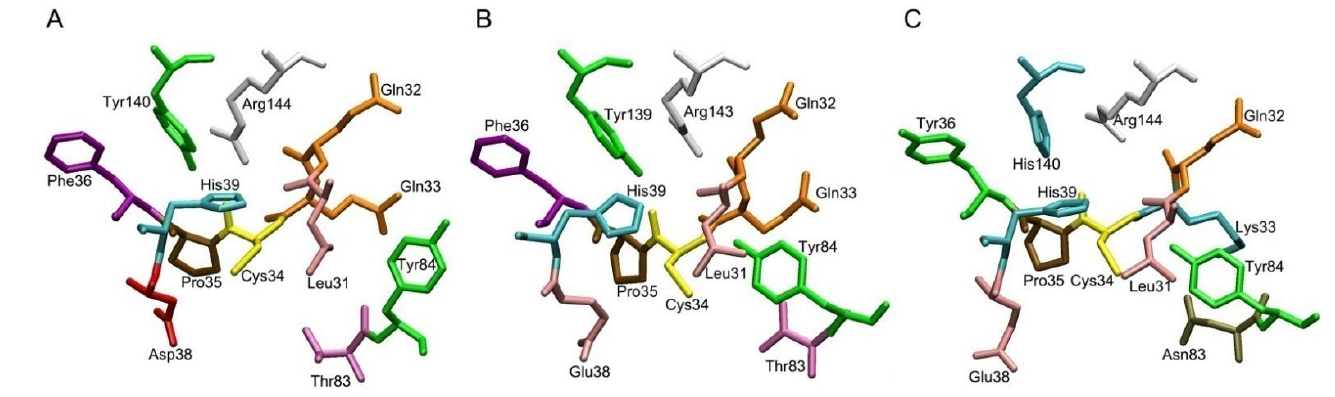
Figure 3. Structures of Sudlow site II of of HSA ( A ), BSA ( B ) and RSA ( C ).